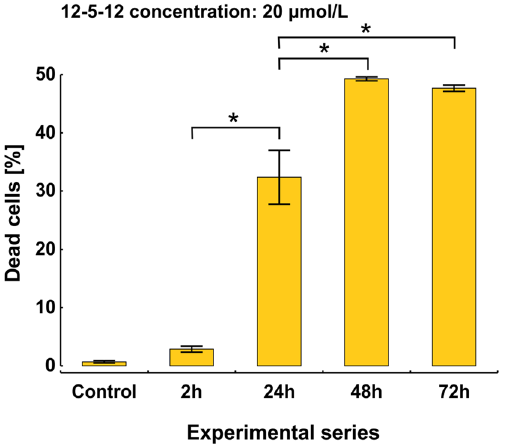
Figure 4. The time-dependent effects on the percentage of dead cells after exposure to the 12-5-12 surfactant at the concentration of 20 μmol/L. The columns show mean values and the error bars represent standard deviation from three independent treatments. Statistical significance was assessed with the one-way ANOVA followed by the post-hoc Tukey’s honestly significant difference (HSD) test. An asterisk indicates statistically significant differences (p <